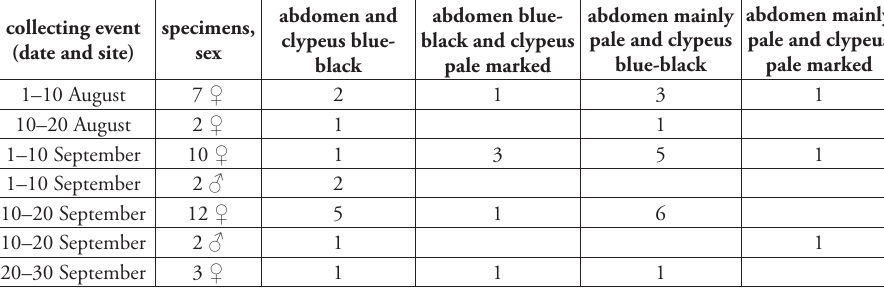
Table 1. Color patterns of clypeus and abdomen in N. albicomus , sorted by collecting event and sex. Intermediate female from 1–10 September not